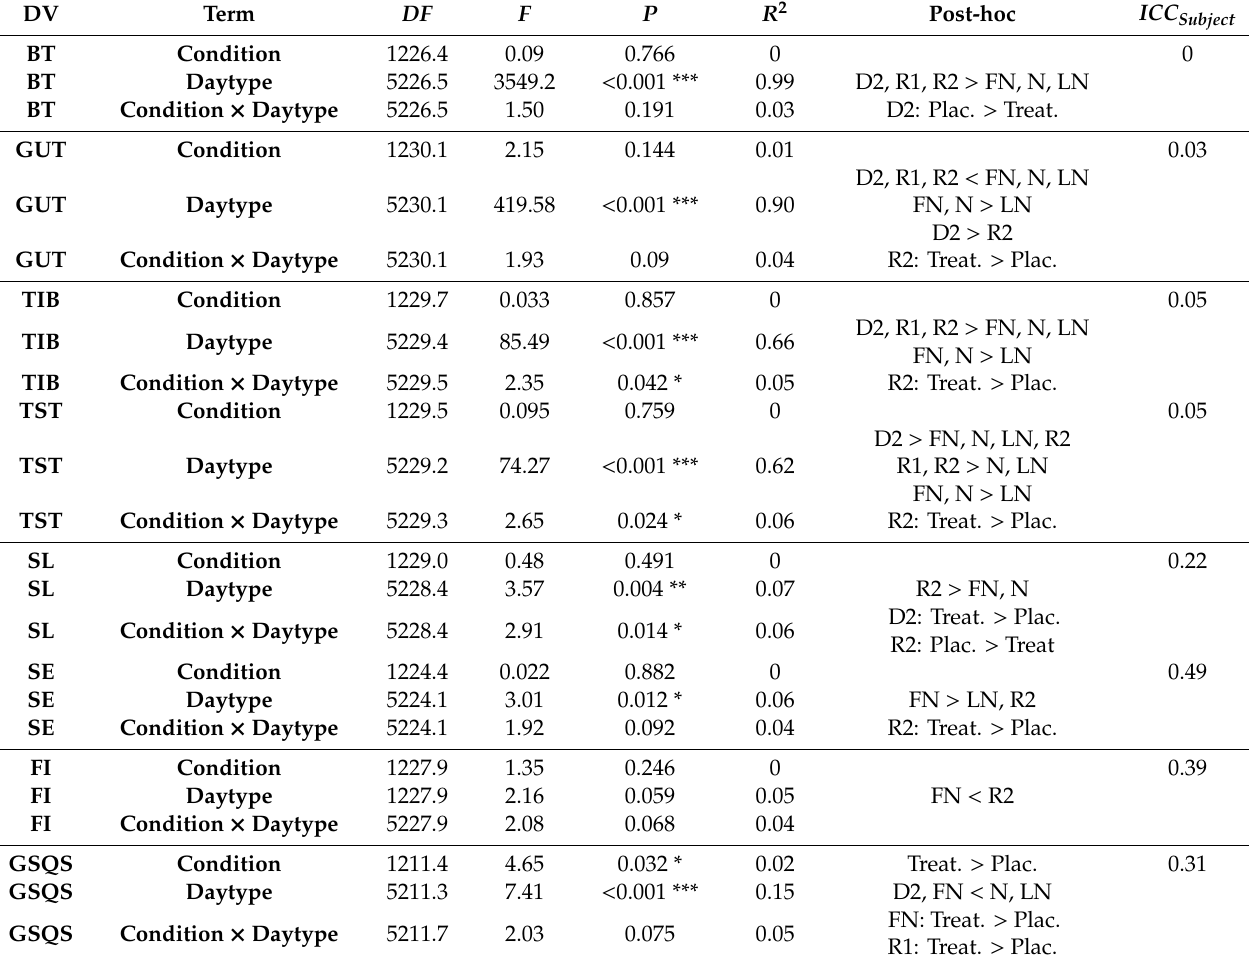
Table A5. Results of the LMM analyses of sleep parameters bed time (BT), get-up time (GUT), time in bed (TIM), total sleep time (TST), sleep latency (SL), fragmentation index (FI), and Groningen Sleep Quality Index